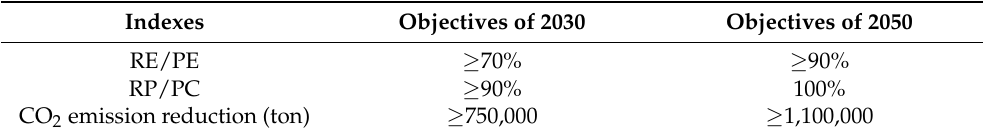
Table 4. The planning objectives and index compliance.